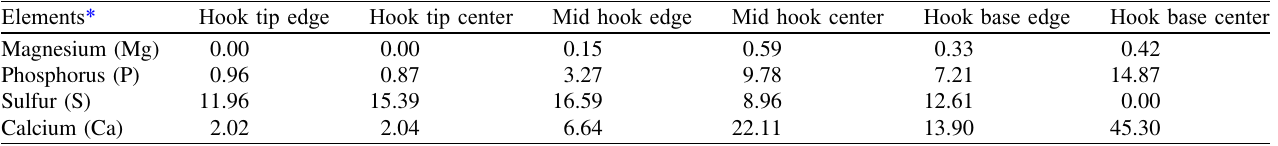
Table 3. X-ray scans for chemical elements of a Gallium cut (LMIS) large hook of Rhadinorhynchus laterospinosus. Elements*